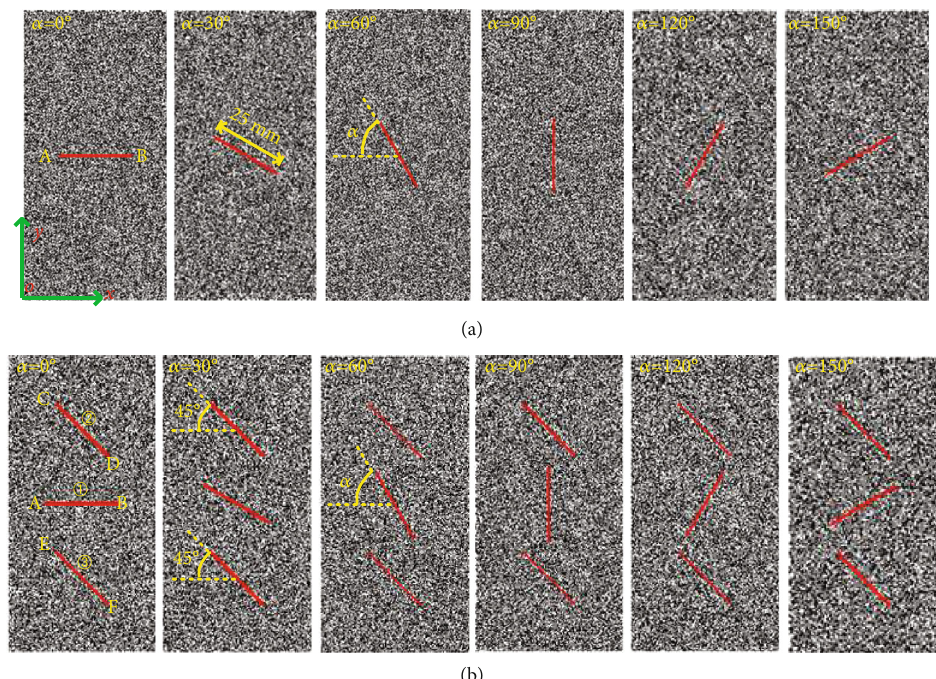
Figure 7: Sandstone specimens with a single precrack and three precracks: (a) sandstone specimen with a single precrack; (b) sandstone specimen with three precracks. Table 2: Mechanical parameters of the smooth joint model [2]. Parameters Value Normal sti ff ness per unit area (GPa) 2 Shear sti ff ness per unit area (GPa) 2 Friction coe ffi cient 0.35 Tensile strength (Pa)